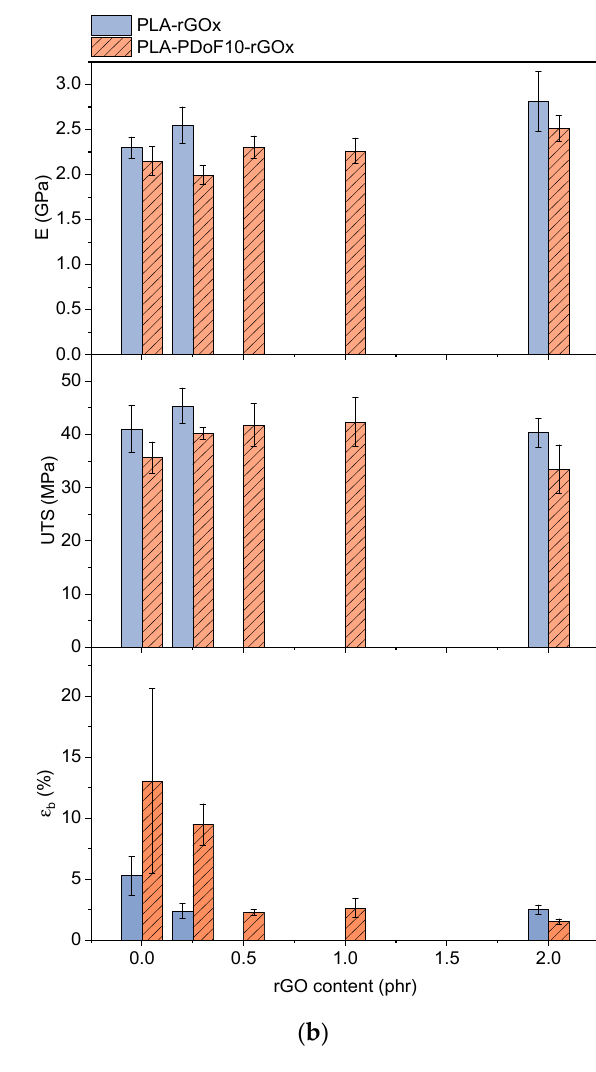
Figure 8. Results of the quasi-static tensile tests on the prepared films. ( a ) Representative stress–strain curves of some selected compositions; ( b ) tensile modulus ( E ), ultimate tensile stress ( UTS ) and strain at break ( ε b ) as a function of the rGO content for the samples PLA-rGOx and PLA-PDoF10-rGOx (x = 0.25 ÷ 2 phr).